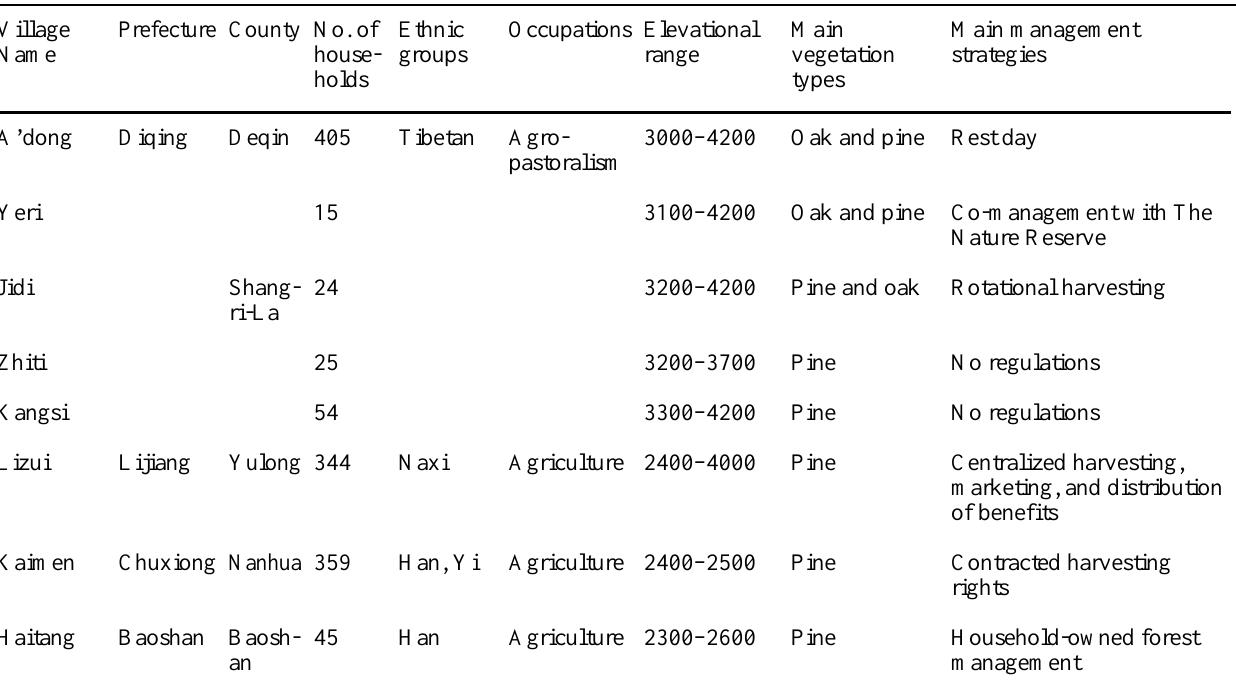
Table 2. Basic information about the study sites. Village